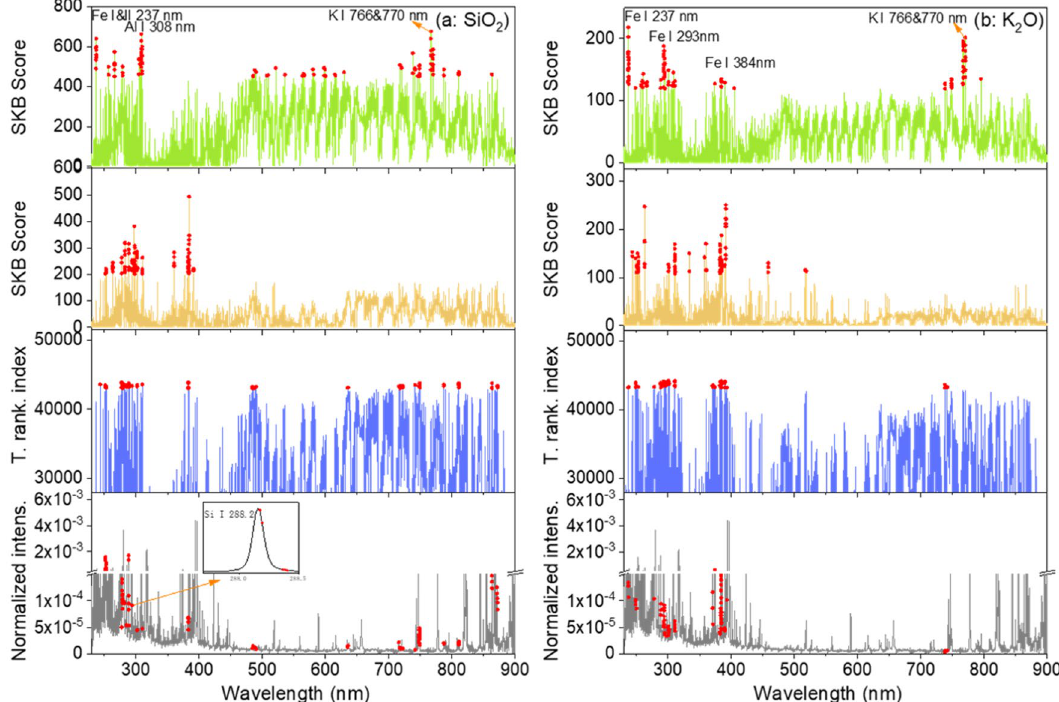
Figure 10. Results of feature selection for the pair of sample types pellets/raw rocks: for ( a ) SiO 2 and ( b ) K 2 O. Detailed captions can be found with Fig. 4.